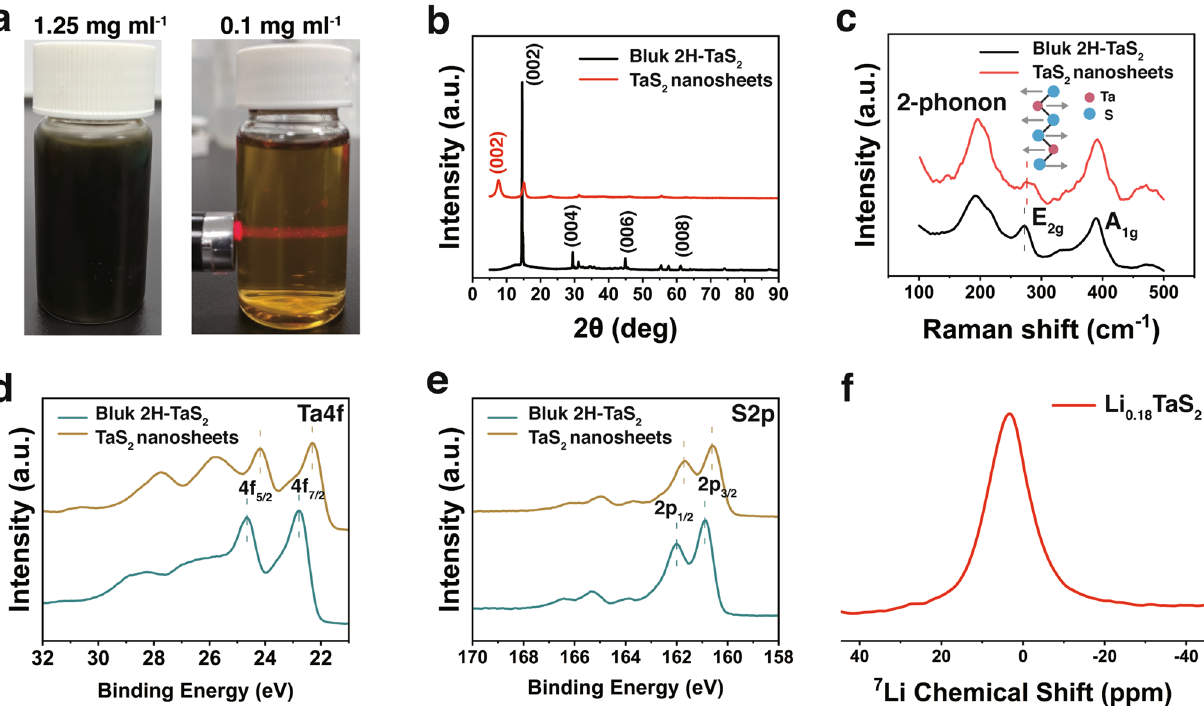
Fig. 2 a Exfoilated 2H-TaS 2 nanosheets aqueous dispersions. b XRD spectra of 2H-TaS 2 crystals and lyophilized 2H-TaS 2 nanosheets. c Raman spectroscopy analysis of the exfoliated nanosheets and the bulk crystal for comparison. XPS high-resolution spectra of d Ta 4 f and e S 2 p of 2H-TaS 2 crystals and lyophilized 2H-TaS 2 nanosheets. f 7 Li SP MAS NMR spectra of 2H-TaS 2